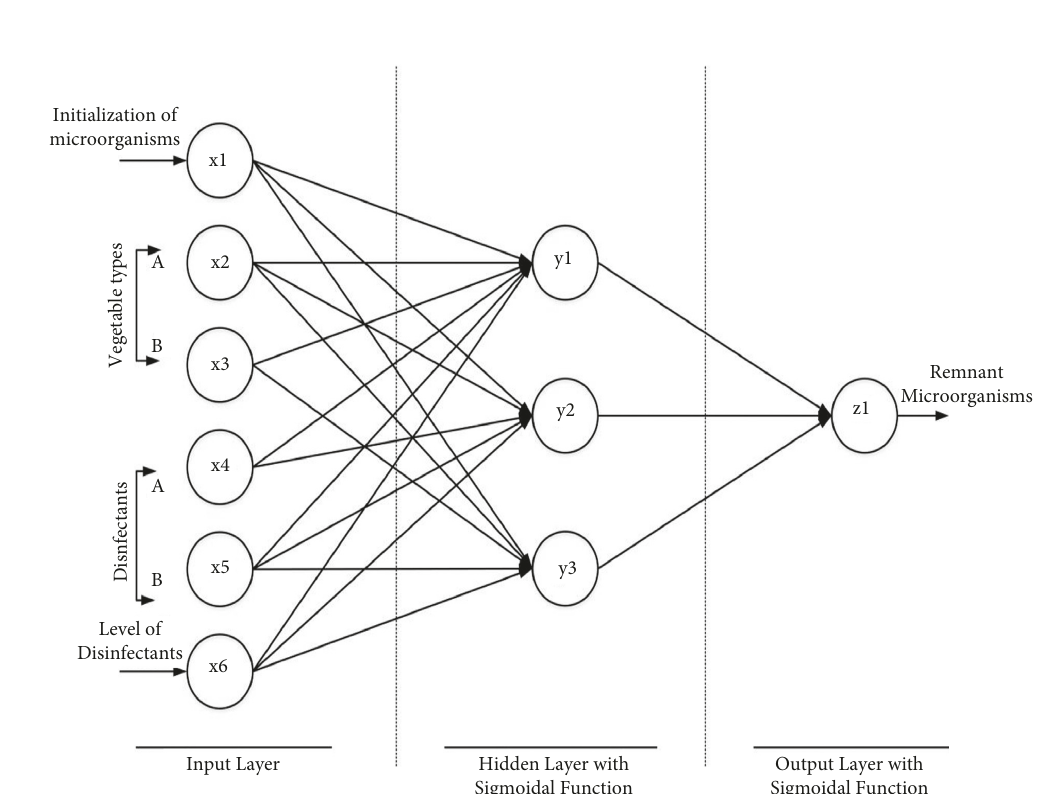
Hidden Layer with Output Layer with Sigmoidal Function Sigmoidal Function